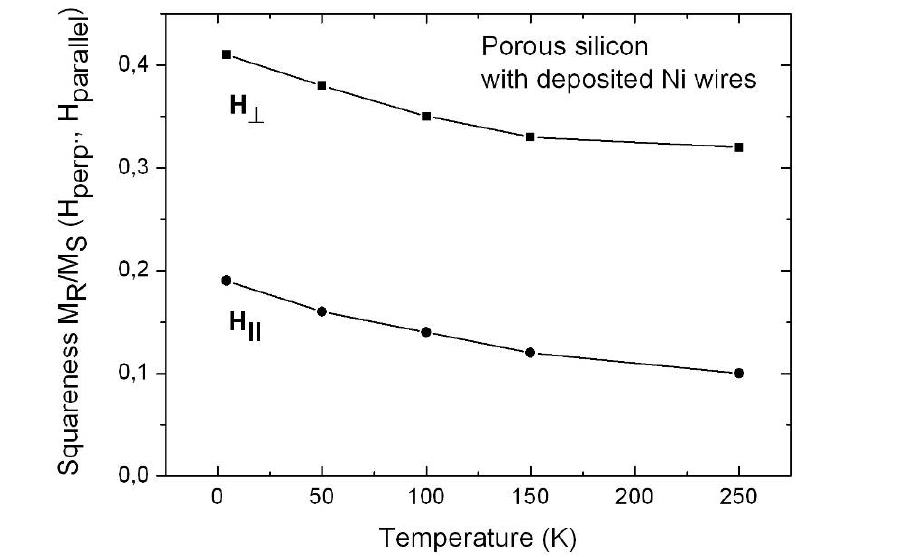
/M ) for easy axis ( ⊥ ) and hard axis ( ⎢⎢ ) magnetization at two R S